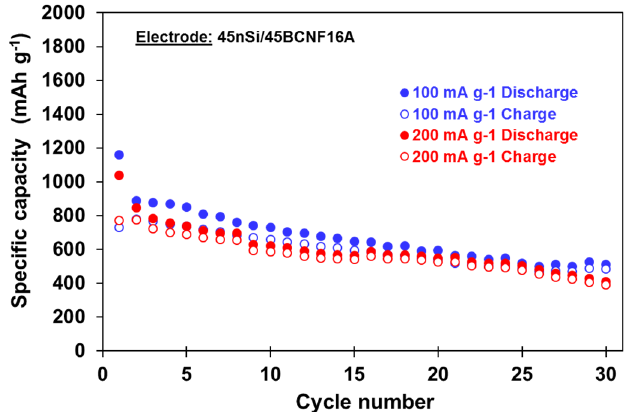
Figure 6. Specific discharge / charge capacity against cycle number plots from the galvanostatic cycling vs. Li / Li + at 100 and 200 mA g − 1 of 45nSi / 45BCNF16A electrode, in the 0.9 V–80 mV potential range.